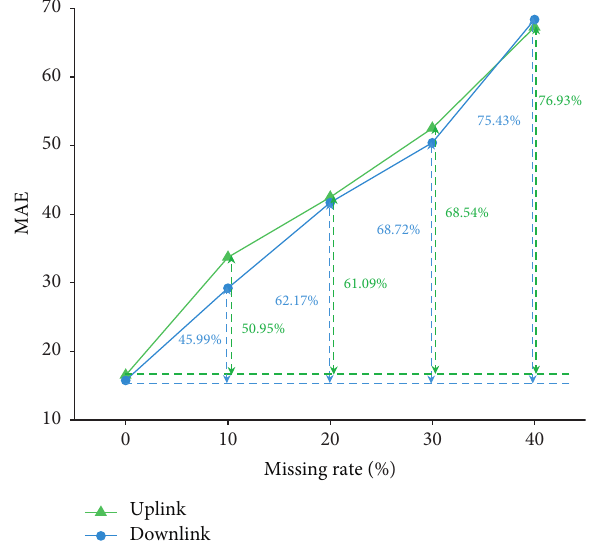
Figure 14: MAE of up-direction and down-direction with different missing rates.